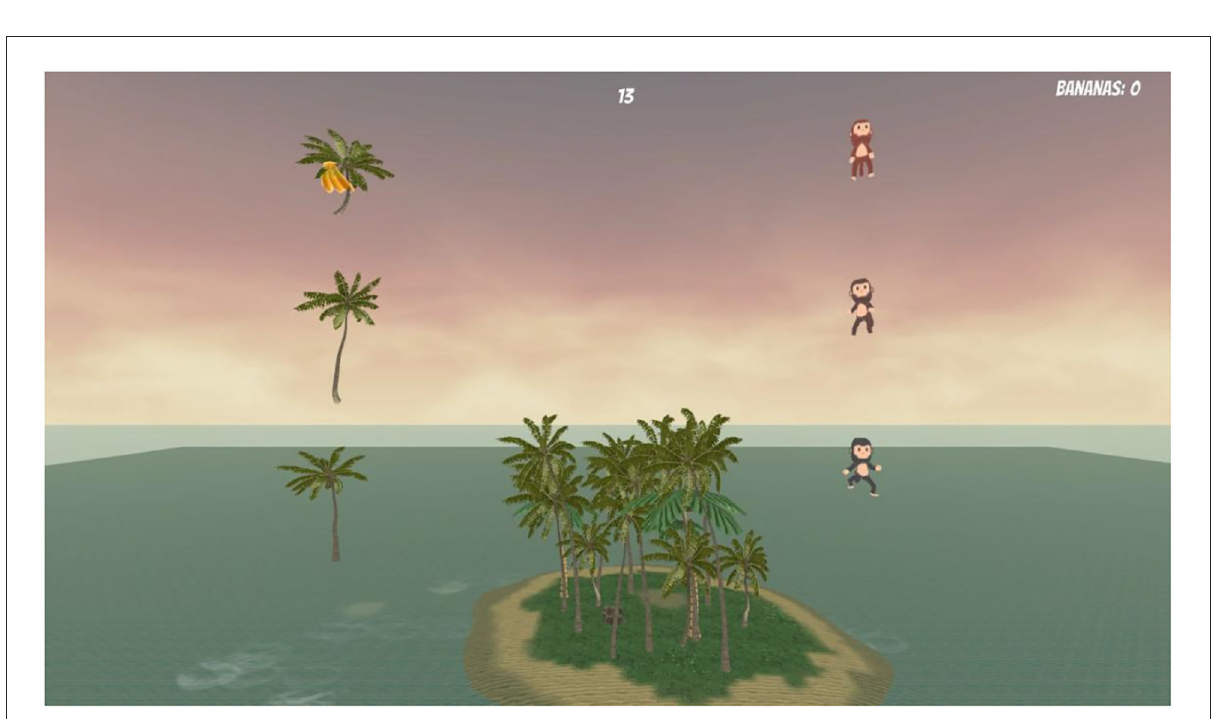
FIGURE7 Mini-game. The user collects the banana with his left hand from the top left tree and brings it to the middle, where he passes it on to his right hand to give it to the bottom right monkey that is making a dance. After a successful try, trees and monkeys switch sides.